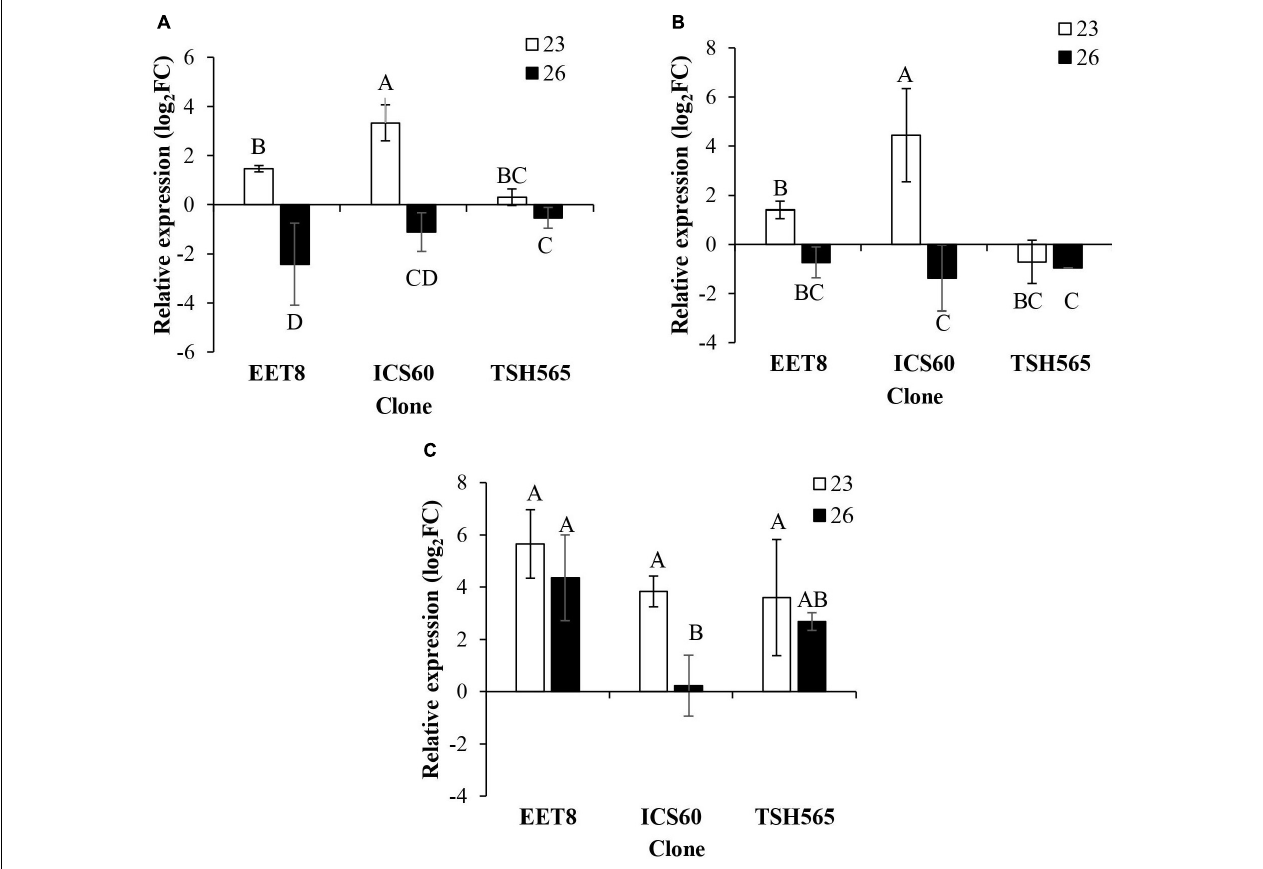
FIGURE 4 | Effect of water deficit on the transcriptional expression of genes encoding fermentative metabolism enzymes. (A) LDH . (B) PDC . (C) ADH . Bars represent the averages of the induction factor (log2-fold change) ± standard deviation ( n = 3) relative to the control (day 0). The letters indicate statistically significant differences between days 23 and 26 of water deficit ( P <